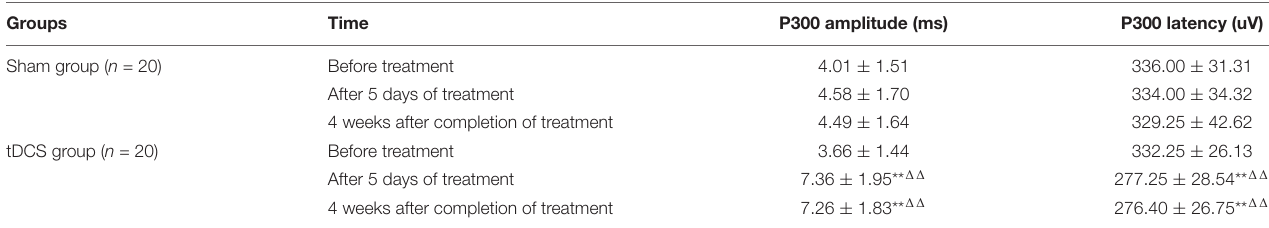
TABLE 3 | Comparison of P300 indexes at each time point between the two groups.